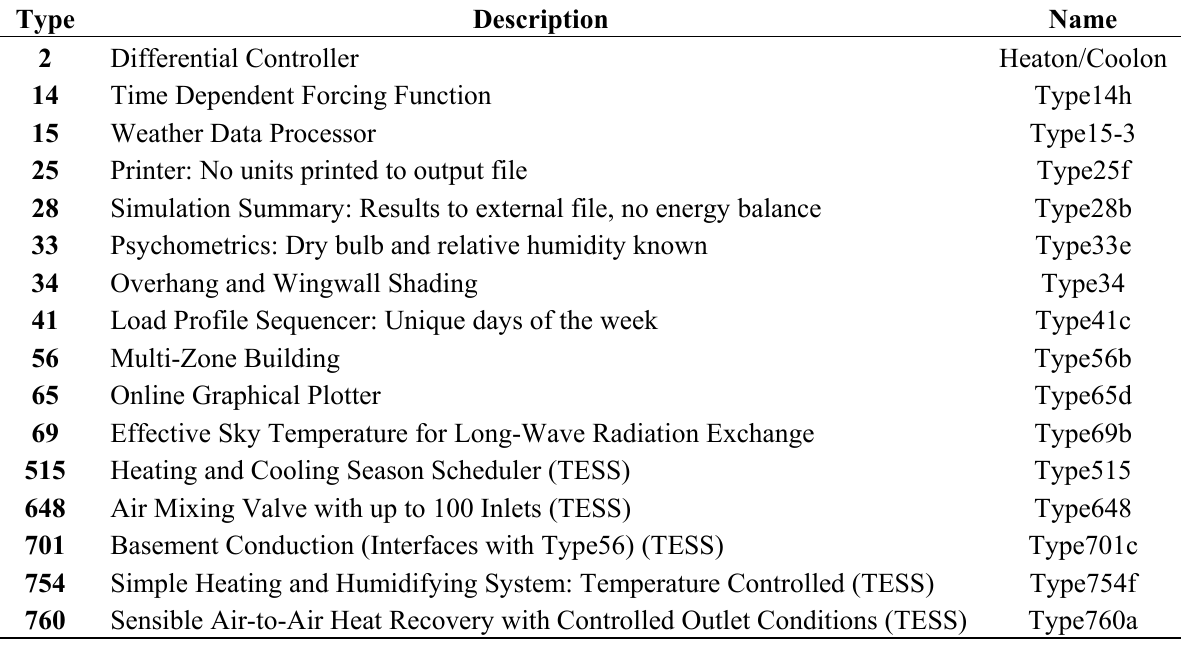
Table 2. Types used in the TRNSYS model of the base case